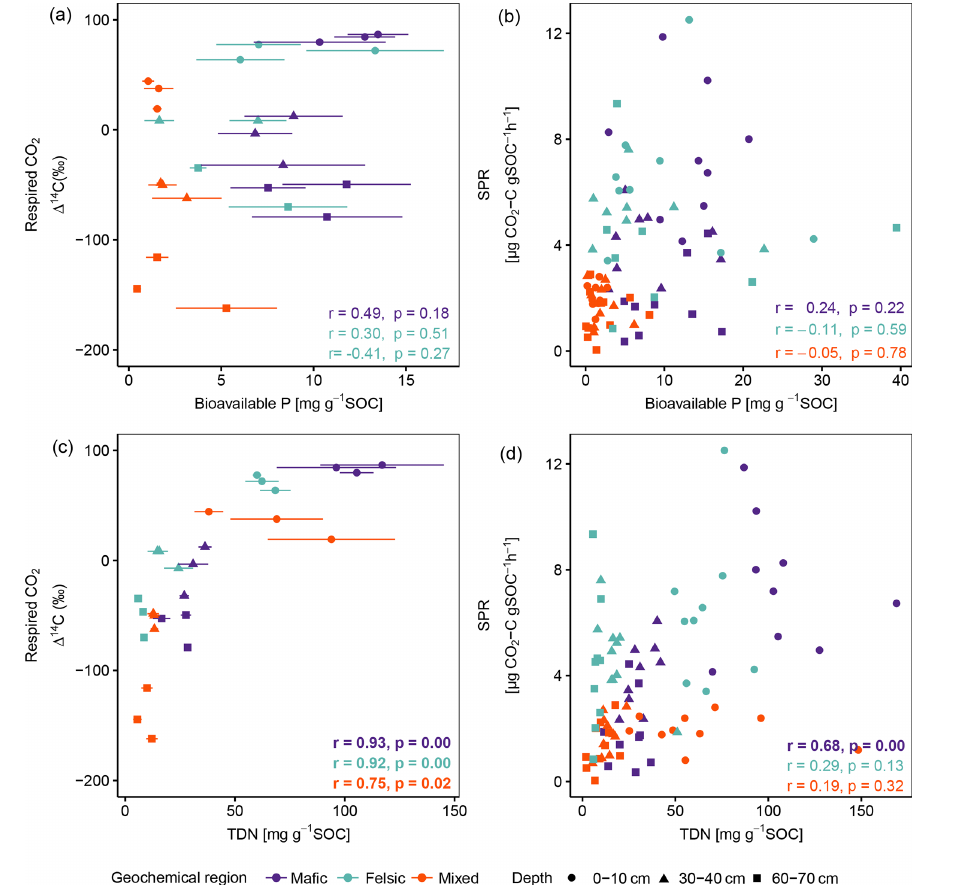
Figure A1. Pearson correlation between the composite of corresponding replicates of (cid:49) 14 C of respired CO 2 and SPR to P- (a,b) and N- (c,d) available nutrient data, reported by Doetterl et al. (2021b), normalized to SOC content for non-valley positions. Data displayed in panels (a) and (c) are averages plus standard errors of three field replicates. Panels (b) and (d) show all individual field replicates. Note that two outliers (artefacts) with high bioavailable P values in subsoil were removed from panels (a) and (b) . p values in bold indicate significant results at p < 0.05. Bioavailable P is Bray P, and TDN is total dissolved nitrogen.